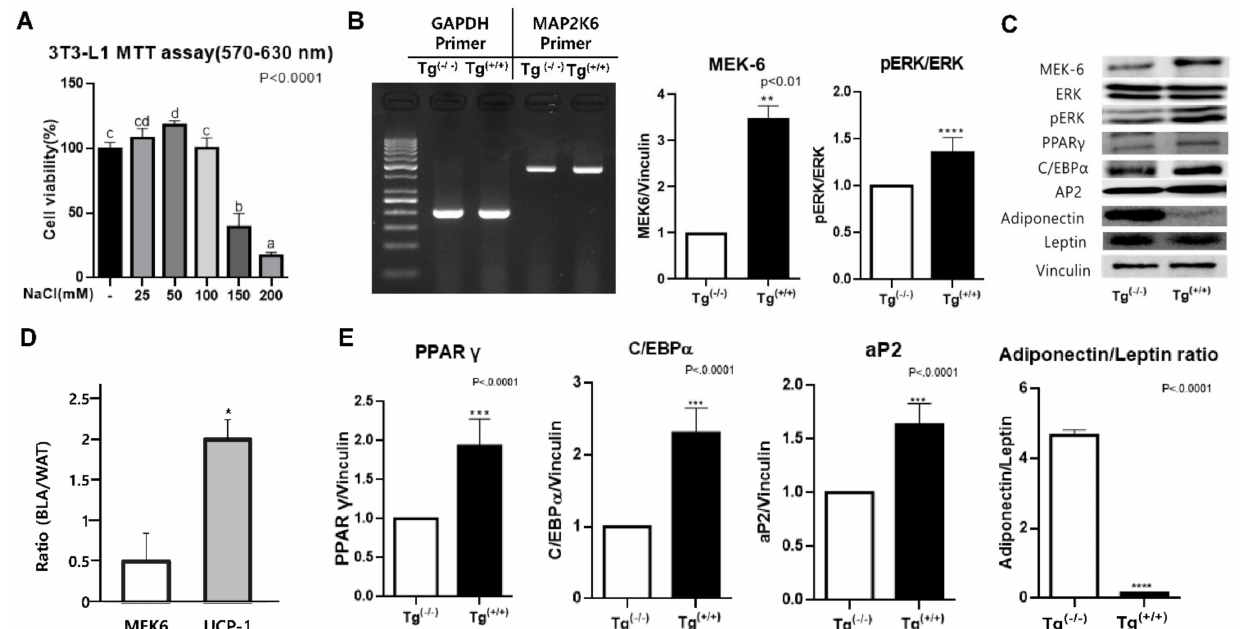
Figure 1. Salt treatment, and characteristics of MEK6 transfection and beiging. ( A ) Salt treatment level (NaCl 50 mM) was determined by cell proliferation assay. Different superscript letters (a, b, c, d) indicate the significant differences by ANOVA test ( p < 0.05). ( B ) MEK6 -transfected adipocytes were confirmed by mRNA and protein levels. ( C ) The expression of proteins related to MEK6 transfection compared to non-transfection. ( D ) The beiging of WAT(BLA) was confirmed by UCP-1 expression and MEK6 was depressed in BLA. ( E ) Adipogenesis biomarkers, PPAR- γ , CEBP- α , aP2 and adiponection/leptin ratio, were increased in MEK6 transfected WAT. Significant differences in individual treatments versus controls were determined by unpaired t -test. *; p < 0.05, **; p < 0.01, ***; p < 0.001, ****; p <